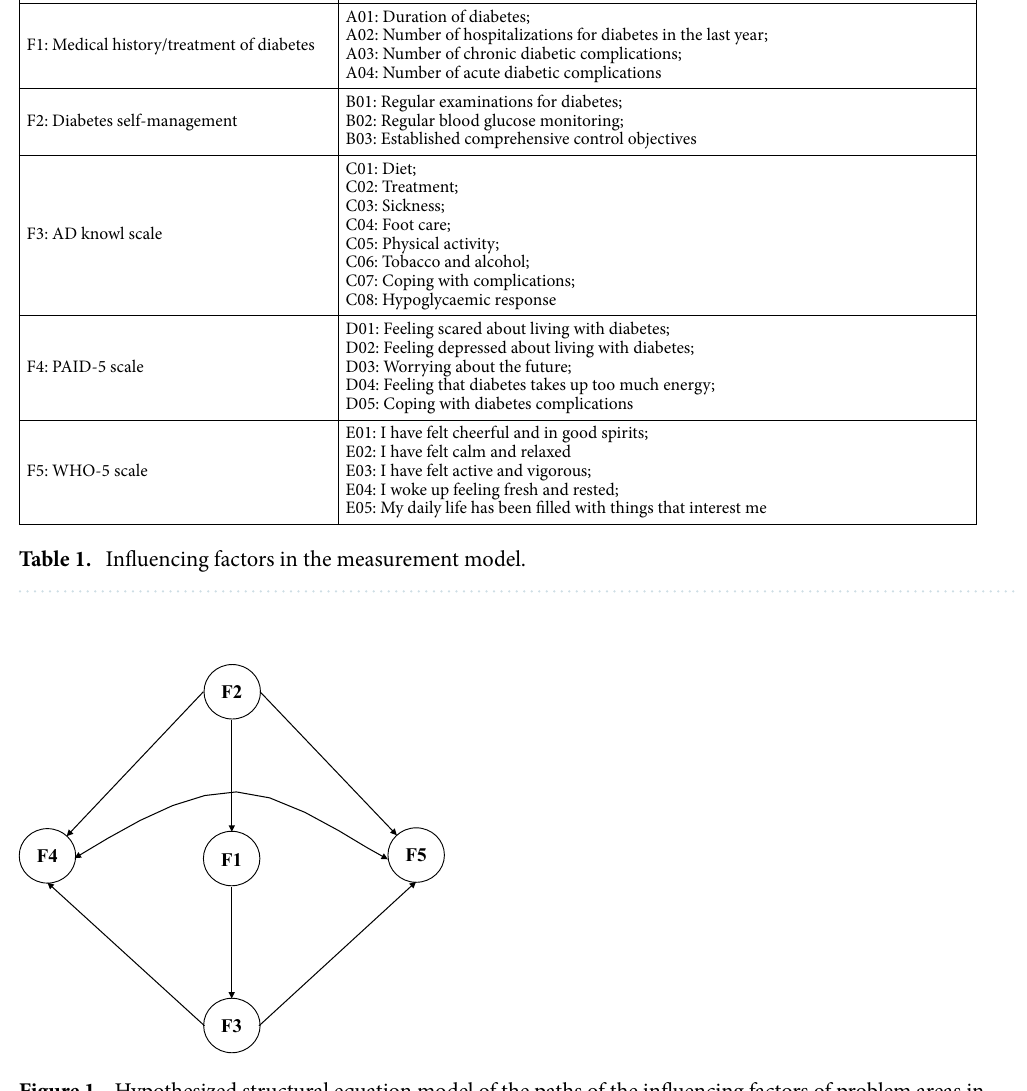
Figure 1. Hypothesized structural equation model of the paths of the influencing factors of problem areas in diabetes and